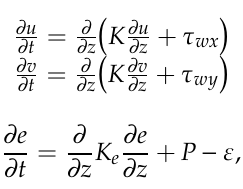
Figure 6. Dependence of the significant wave height on wind velocity 10 U and inverse wave age Ω Ω : 1— =1, 2—1.3; 3—1.6; 4—1.9; 5—2.2; 6—2.5 7—2.8. A horizontal dotted line separates the p p